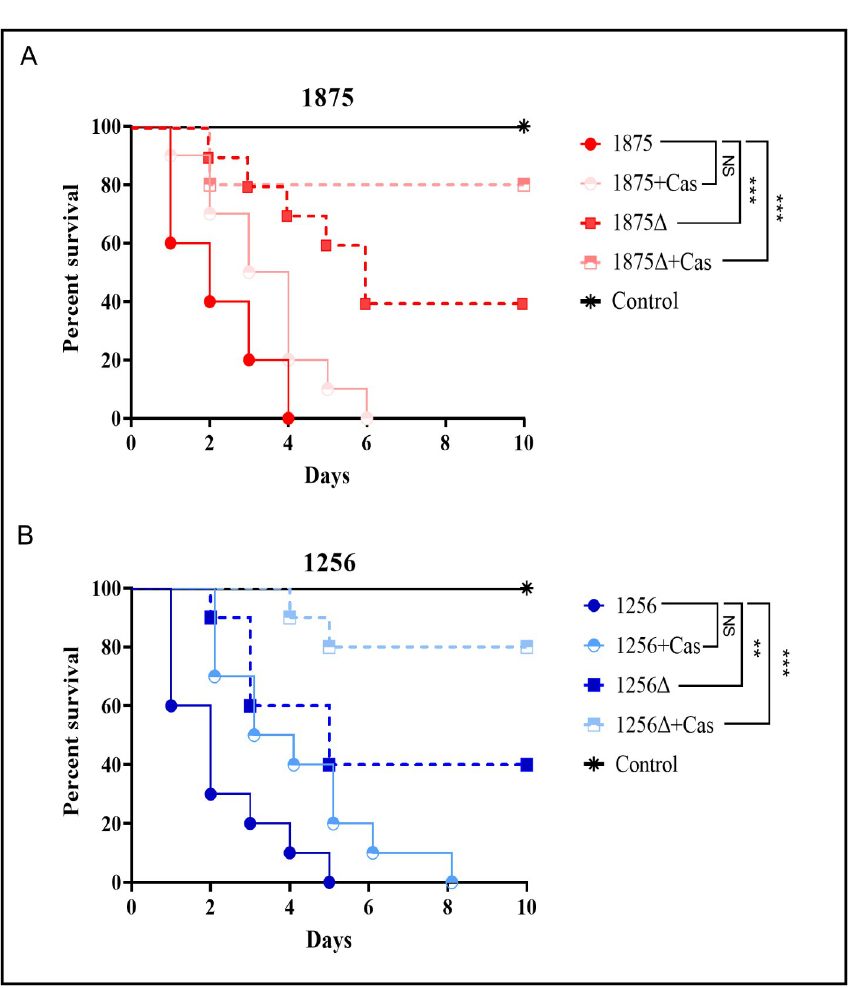
Fig 5. Time-kill curves. A C . glabrata 1875 B 1256, wild type (circle) and crz1 Δ (square) exposed to caspofungin 100 mg/L. The data are expressed as the percentages of survival. Log-rank (Mantel–Cox) test with p-values of < 0.05 was used to indicate statistical significance. As follows, p < 0.05 � p < 0.02 �� and p < 0.001 ��� . Not significant